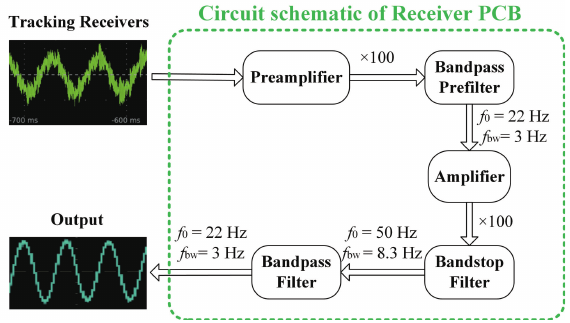
Figure 10. The signal processing circuit for the dual receivers tracking system.